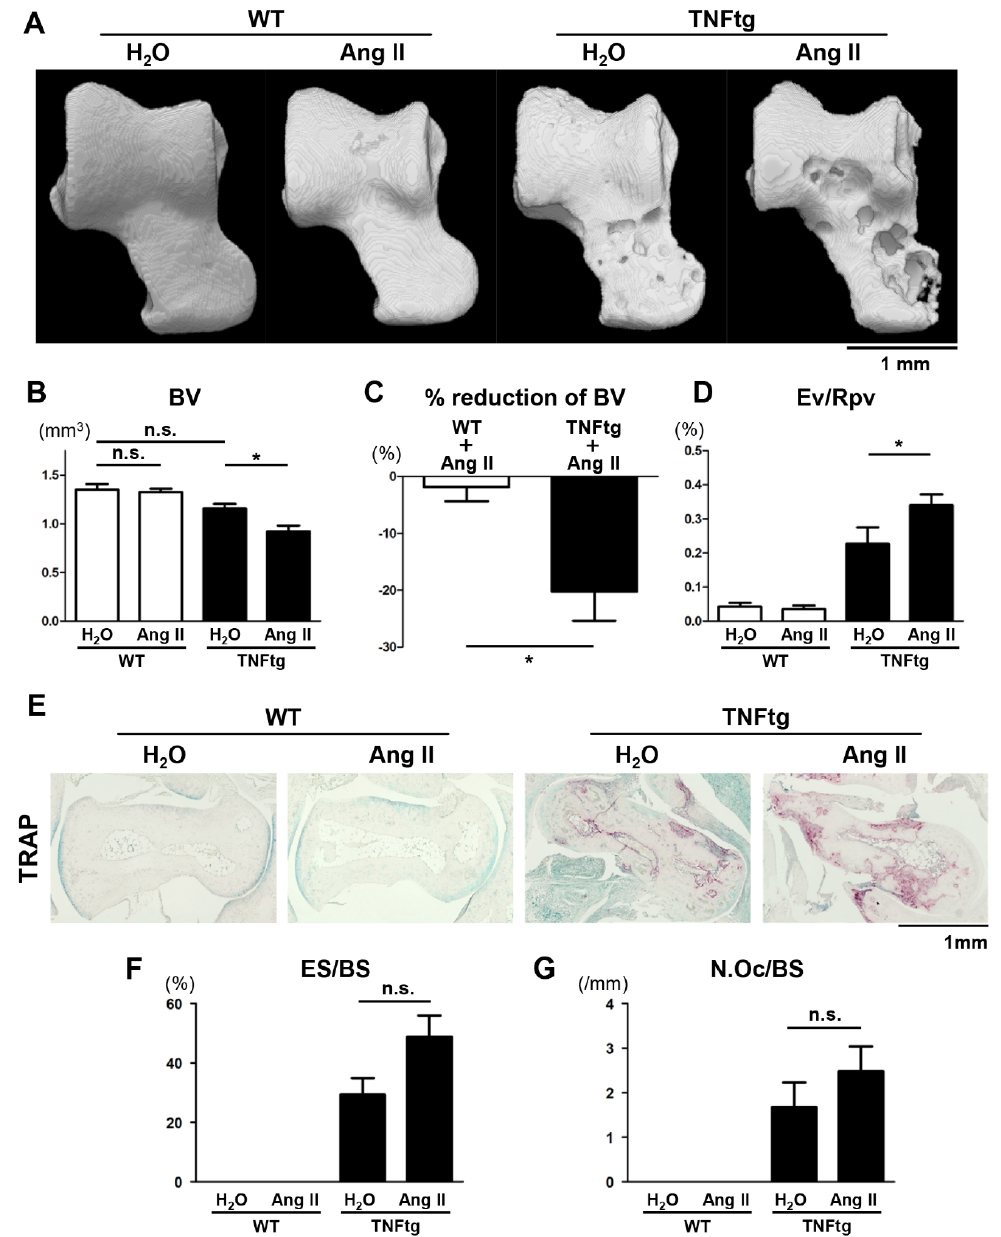
Figure 2. Exacerbation of bone erosion by angiotensin II (Ang II) administration in tumor necrosis factor-transgenic (TNFtg) mice. Ang II was administered by osmotic pumps to WT ( n = 6) and TNFtg ( n = 7) male mice from 12 to 16 weeks of age. Water (H 2 O) was administered by osmotic pumps to WT ( n = 6) and TNFtg ( n = 4) male mice as controls. ( A ) Representative 3D micro-computed tomography (CT) images of the talus. ( B ) Bone volume (BV) of the talus. ( C ) Rates of reduction in BV of Ang II-infused WT and TNFtg mice relative to H 2 O-infused control mice of each genotype. ( D ) Eroded volume per repaired volume (Ev/Rpv) of the talus. ( E ) Representative images of tartrate-resistant acid phosphatase (TRAP) staining around the talus bones of indicated mice; original magnification ×40. ( F ) Eroded surface per bone surface (ES/BS) around the taluses. ( G ) The number of osteoclasts per bone surface (N.Oc/BS) around the taluses. Values are the mean ± SEM. n.s., not significant. *, p < 0.05.